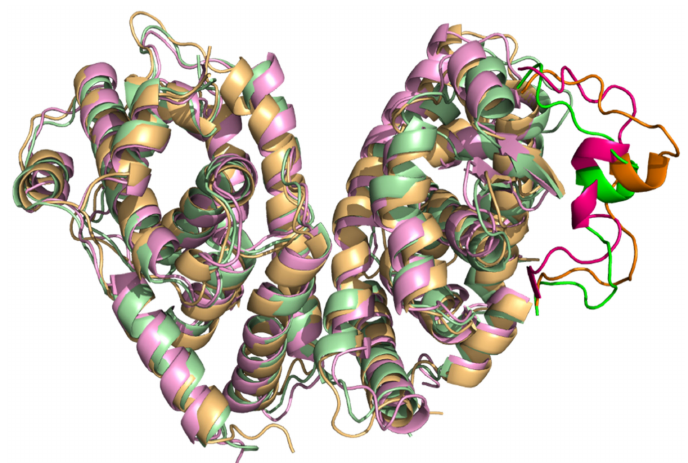
Figure 8. Alignment of RXR α -FXR in complex with 9-cis-RA and JN3 respectively at 0 ns, 125 ns, and 250 ns. Only relevant conformational changes have been